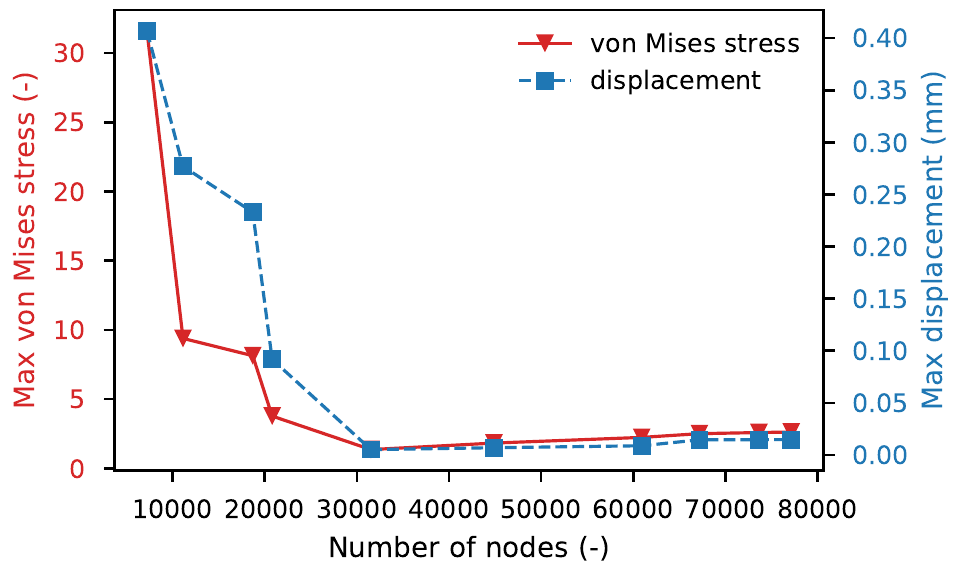
Figure 10. Structural variables’ evolution with the number of